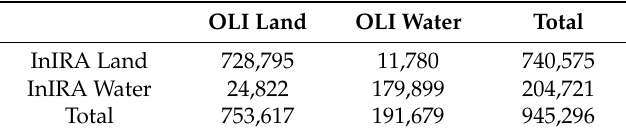
Table 3. Error matrix for the classification results of Image A.